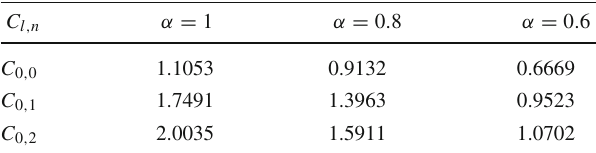
Table 1 Numerical values of the normalization constant, Eq. (27), con- sidering different values of α for l = 0, κ = 1 and ω/ m = 0 . 5 C l , n α = 1 α = 0 . 8 α = 0 .